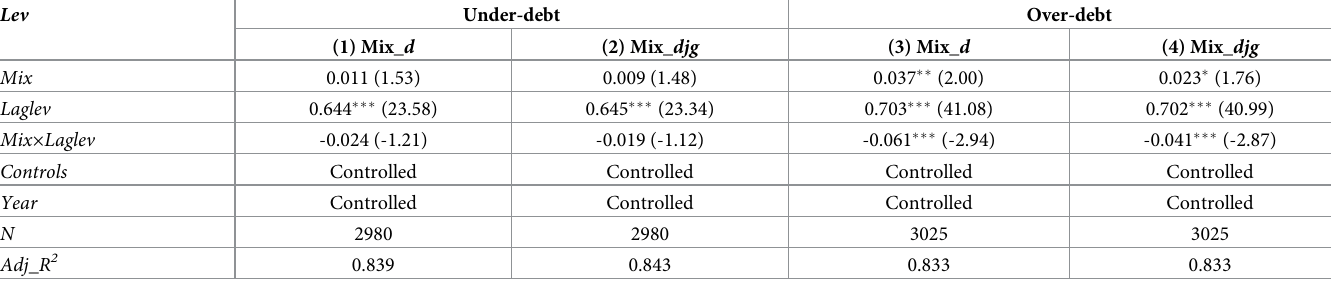
Table 5. The non-state-owned shareholder ‘s governance and the speed of the capital structure adjustment.